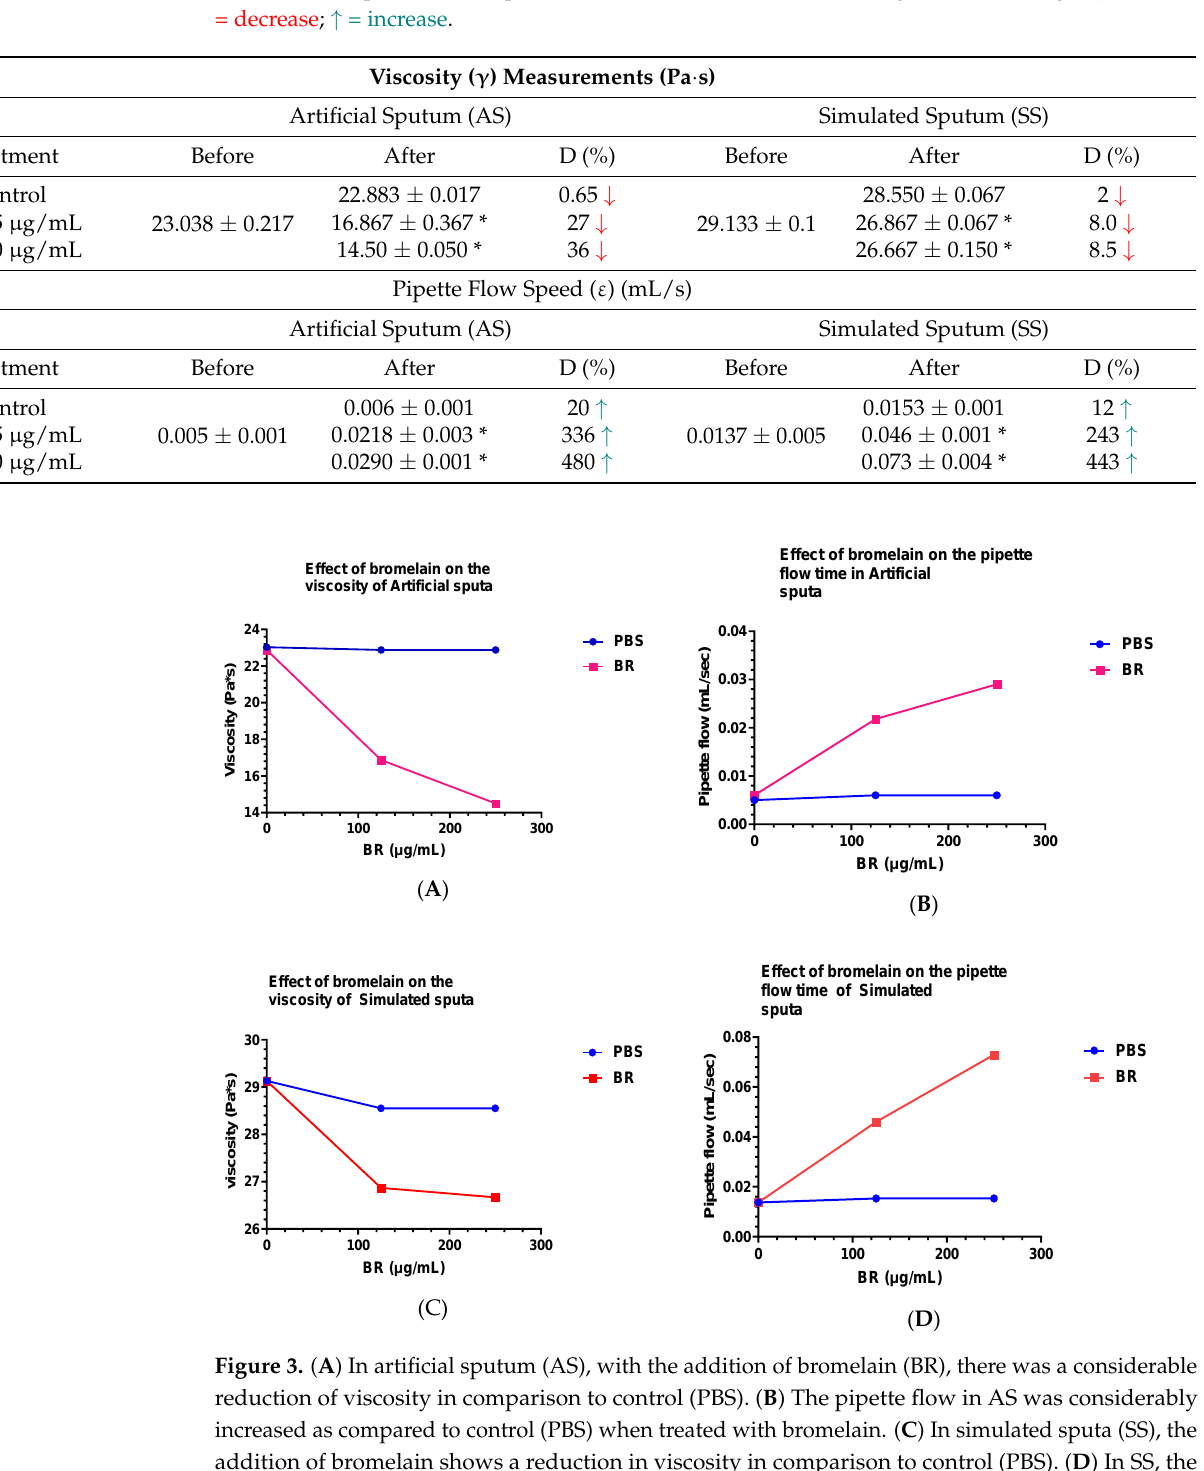
Table 2. The effect of aerosolized N-Acetylcysteine on both artificial and simulated sputa using two parametric measurements such as viscosity and pipette flow time. NAC: N-Acetylcysteine. Data presented as mean ± SD. Test samples were compared with control after treatment for significance testing; *: p < 0.05; ↓ = decrease; ↑ = increase.